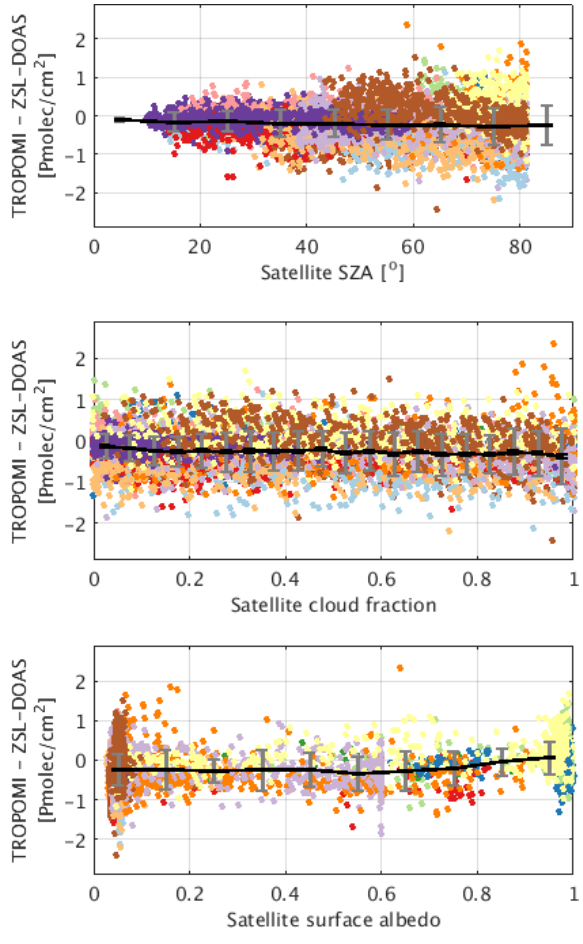
Figure 7. Dependence of the difference between TROPOMI NRTI and ground-based ZSL-DOAS stratospheric NO 2 column data on the satellite solar zenith angle (SZA), satellite cloud fraction, and satellite surface albedo, including a median and IP68/2 spread per bin (bin widths of 10 ◦ in SZA, 0.05 in CF, and 0.1 in surface albedo). Different colours represent different stations, to illustrate the (modest) impact of station–station network inhomogeneity on these